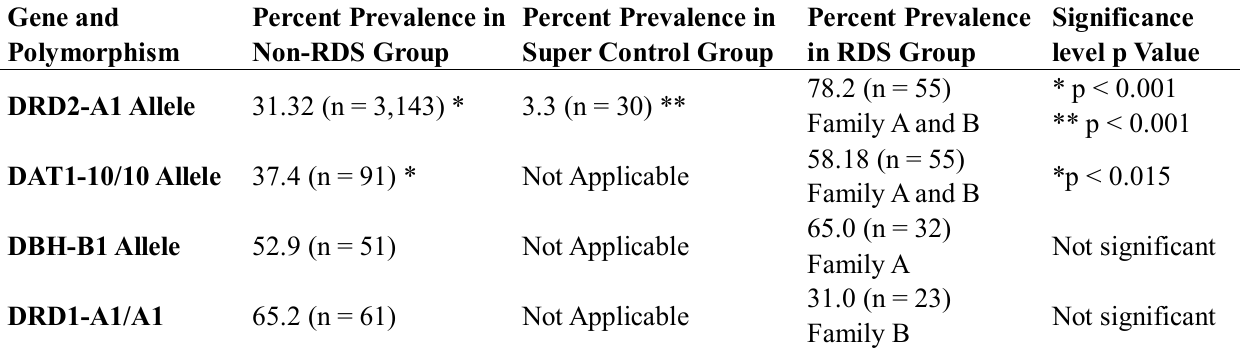
Table 2. Genotype results for dopaminergic genes in Family A and Family